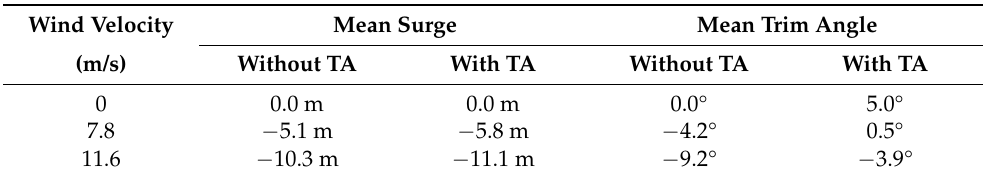
Table 4. Experimental results for mean surge and hull trim for different wind conditions with and without trim adjustment (TA).